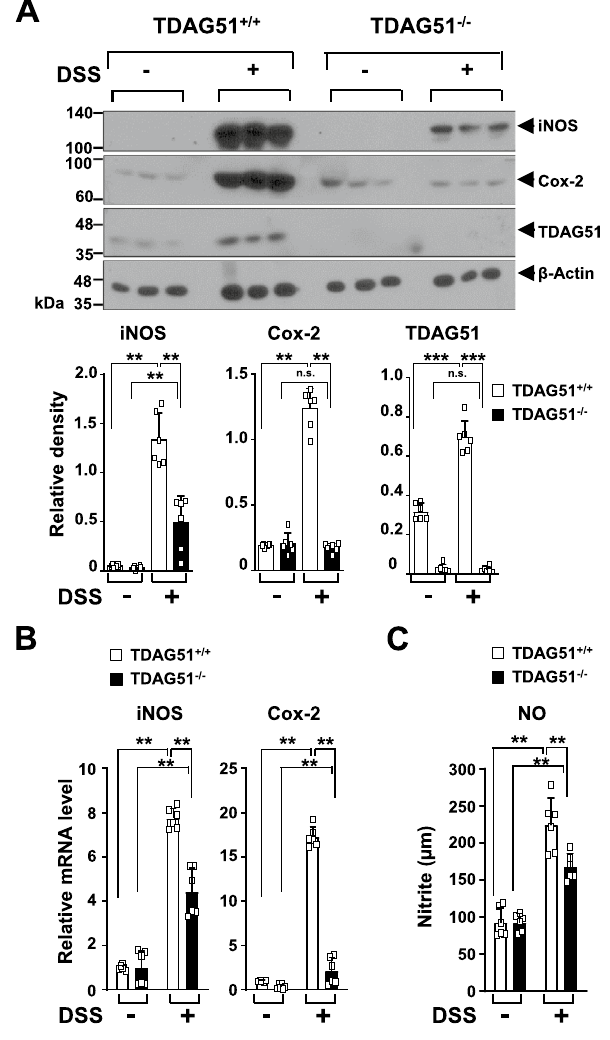
Figure 4. TDAG51 deficiency decreases DSS-induced production of inflammatory enzymes. ( A ) The protein levels of iNOS and Cox-2 were measured by immunoblotting analysis. C57BL/6J male mice (8 weeks old, n = 12–14 per group) were administered 1.7% DSS in drinking water for 4 days followed by water for 3 days in 3 cycles. At day 21, three mice were randomly selected from each group for sacrifice. The distal anorectal region of colons was collected and analyzed by immunoblotting (top panel). The relative density was analyzed (bottom panel). β-Actin was used as a loading control. ( B ) The mRNA levels of iNOS and Cox-2 were measured by real-time PCR. The data were normalized to β-actin levels. ( C ) The production of NO was analyzed. ** P < 0.01. *** P < 0.001. n.s. not